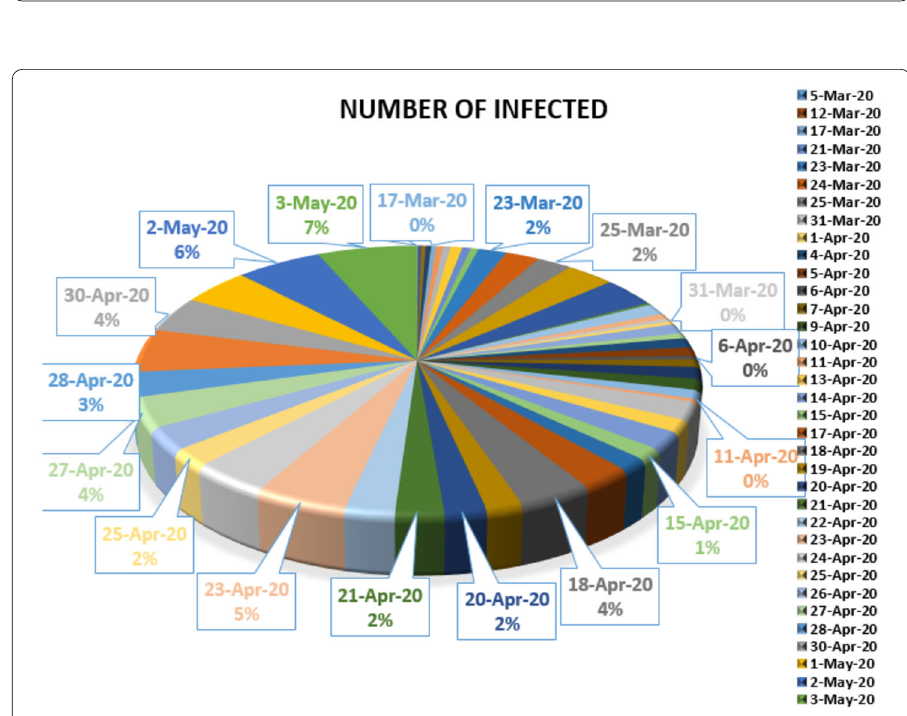
which is polynomial of sixth order. For this polynomial, R 2 was calculated as 0.9978. We present a simulation of the polynomial fitting for infected people from 5 March 2020 to